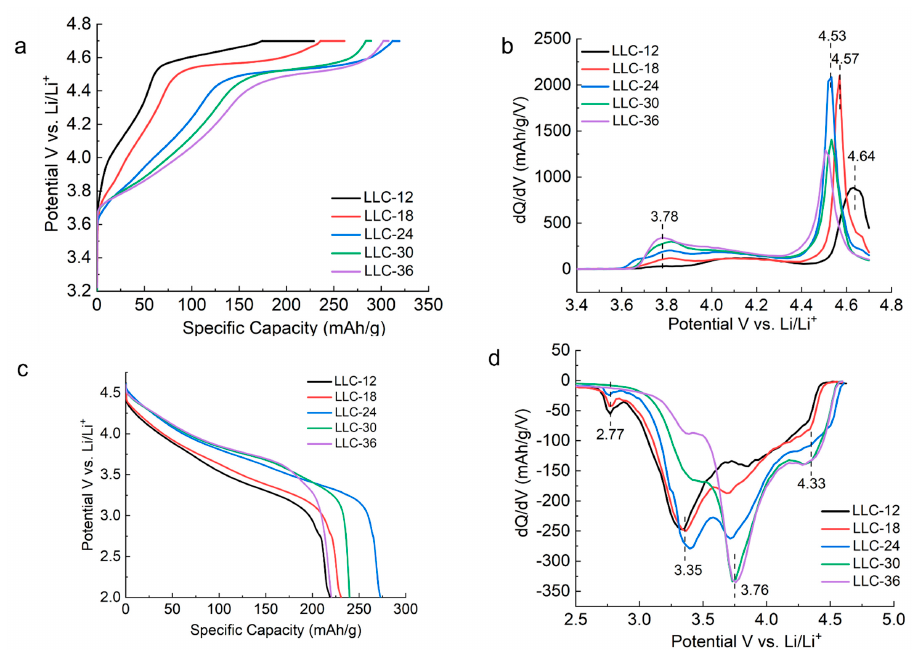
Figure 3. ( a ) First − cycle specific charge capacity vs. voltage curve. ( b ) Differential capacity (dQ/dV) plots for 1st cycle charging. ( c ) First–cycle specific discharge capacity vs. voltage curve and ( d ) differ- ential capacity (dQ/dV) plots for 1st cycle discharge for all the LLC electrodes. Cells were cycled between 2.0 and 4.7 V at a C/20